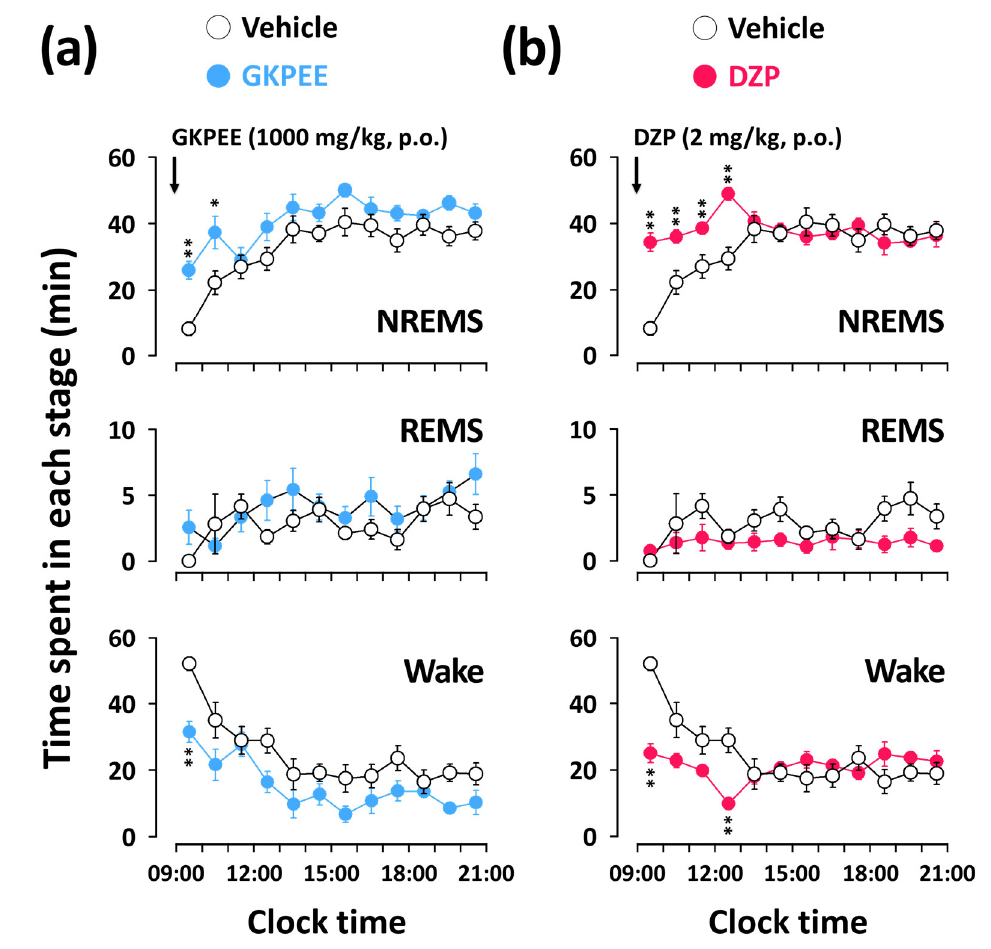
Figure 3. Effects of GKPEE ( a ) and DZP ( b ) on time-course changes in amounts of NREMS, REMS, and Wake during 12 h in mice. Open circle indicates the vehicle and blue and red filled circles represent GKPEE and DZP, respectively. * p < 0.05 and ** p < 0.01 were considered significant as compared to the vehicle (paired Student’s t-test). DZP, diazepam; GKPEE, green kiwifruit peel ethanol extract; REMS, rapid eye movement sleep; NREMS, non-REMS; SEM, standard error of the mean; Wake, wakefulness.